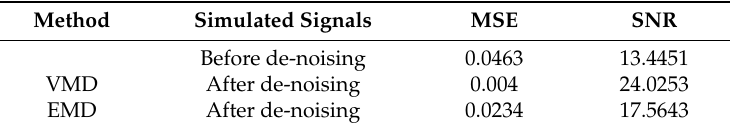
Table 1. MSE and SNR of simulated signals.